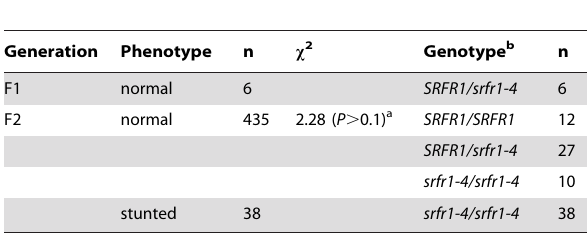
Table 2. A second recessive Col-0 allele is required for stunting in the cross RLD 6 srfr1-4 .